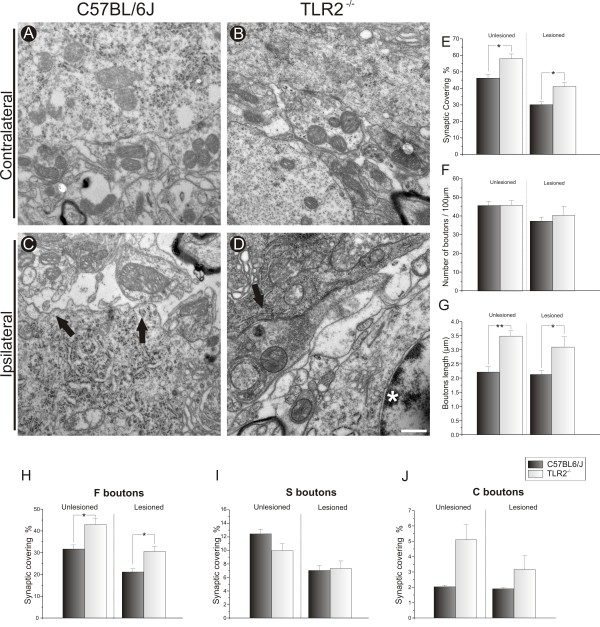
Quantitative ultrastructural analyses of the number of synaptic terminals apposed to the surface of motor neurons after axotomy. Representative micrographs of the surface of (A,B) contralateral and (C,D) ipsilateral motor neurons from C57BL/6J wild-type (WT) and TLR2−/− mice strains. At1 week after peripheral lesion, (C) WT mice had greater detachment of synaptic terminals compared with (D) TLR2−/− mice. The black arrows indicate the location of motor-neuron membrane surfaces from which synaptic terminals were (C) detached from or (D) in contact with the surface of the motor neuron, and the white asterisk indicates an astrocyte close to a synaptic terminal. (E) Graph of the total synaptic covering in unlesioned and lesioned neurons; there was greater synaptic covering in WT mice compared with TLR2−/− mice on both sides. (F) Graph of the total number of synaptic terminals per 100 μm of motor-neuron membrane in lesioned and unlesioned neurons; note the absence of a difference between strains. (G) Graph of the bouton length on the motor-neuron membrane in lesioned and unlesioned neurons, showing differences before and after axotomy. (H-J) Graphs of F-, S- and C-terminal numbers per 100 μm of motor-neuron membranes, respectively; a greater loss of F-type terminals was seen 1 week after axotomy in WT mice. * P<0.05, ** P<0.01. Scale bar: 0,5 μm.